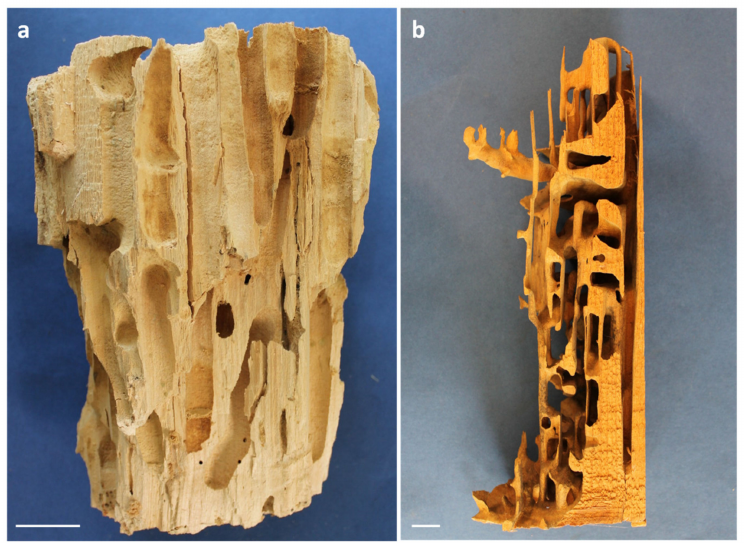
Figure 2. Damages caused by members of Hymenoptera in wood. ( a ) Breeding galleries bored by Xylocopa sp. (Apidae) in poplar wood. Bar = 2 cm. ( b ) Nest built by Camponotus sp. (Formicidae) in a wooden element. Bar = 2